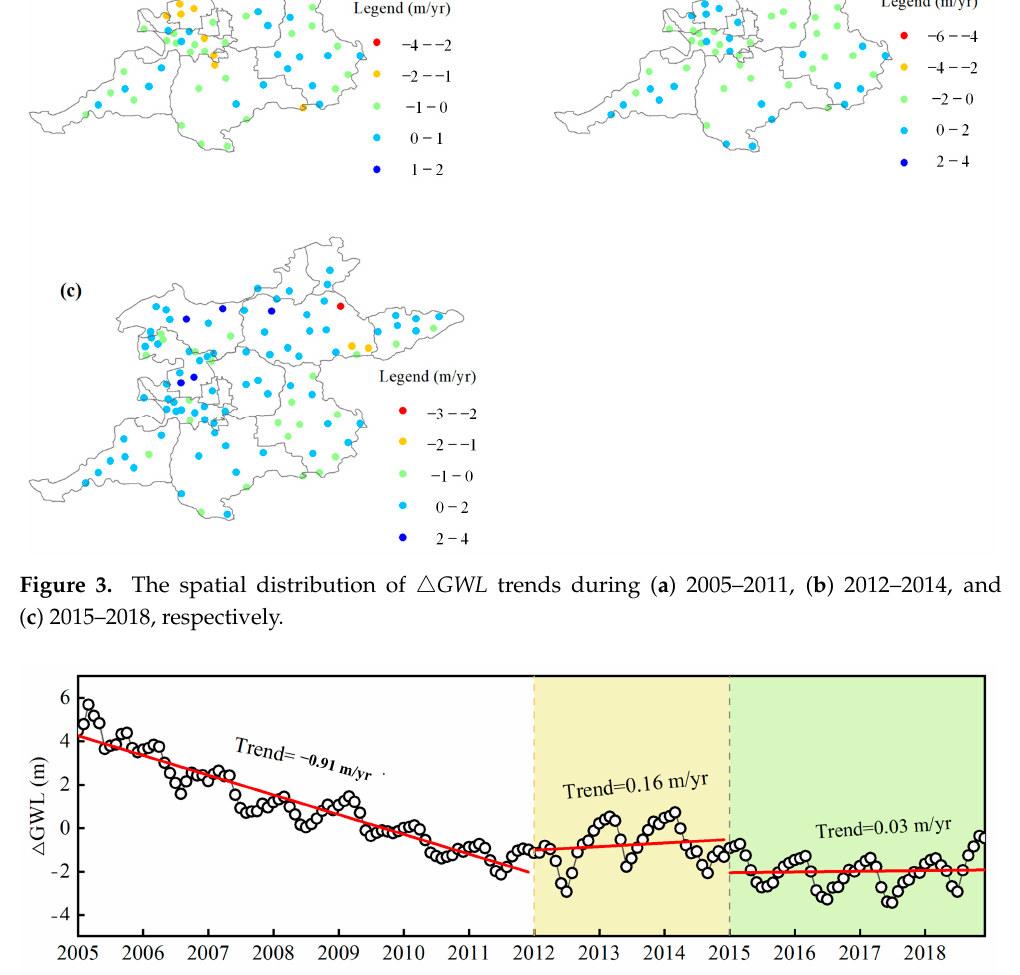
Figure 6a reflects the cumulative deformation of the Beijing Plain from 2017 to 2020. For subsequent combined inversion, the vector map is converted into a grid map at a resolution of 0.05 ◦ , as shown in Figure 6b. It is found that major regions are stable without evident deformation. In terms of spatial distribution, deformations are mainly located in the border zone among Chaoyang, Tongzhou, Changping, and Haidian, forming four